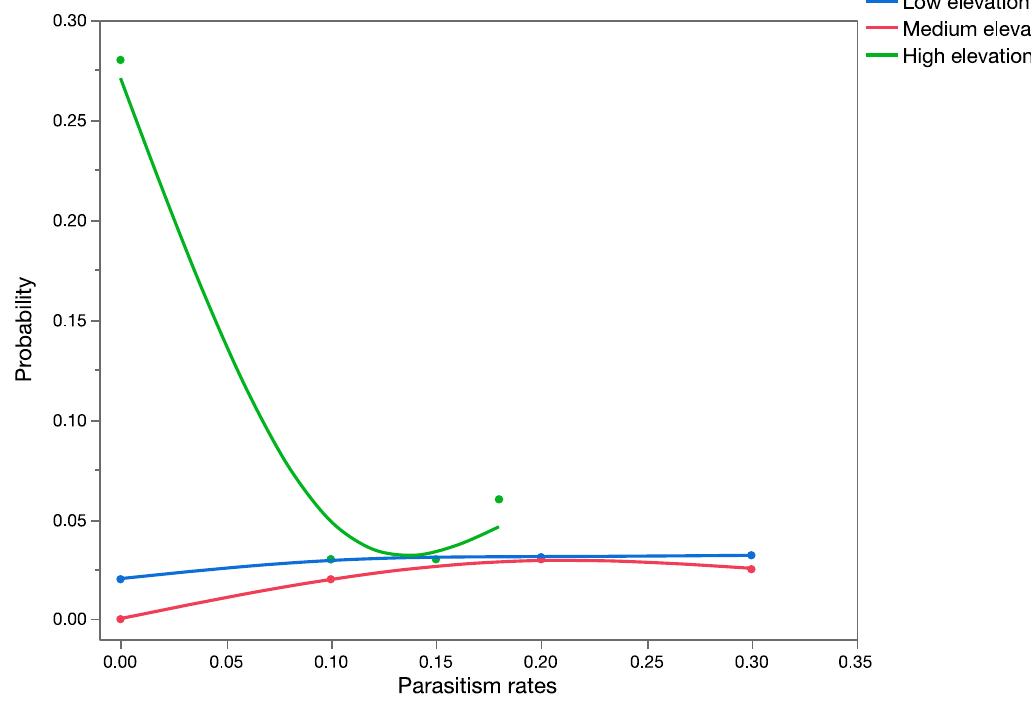
Figure 8. Overlay chart, showing forecast of all possible parasitism rates (as a proportion on the x-axis) for T. flavoorbitalis at low-, medium-, and high-elevation sites using data from retrospective studies in Hawaii.